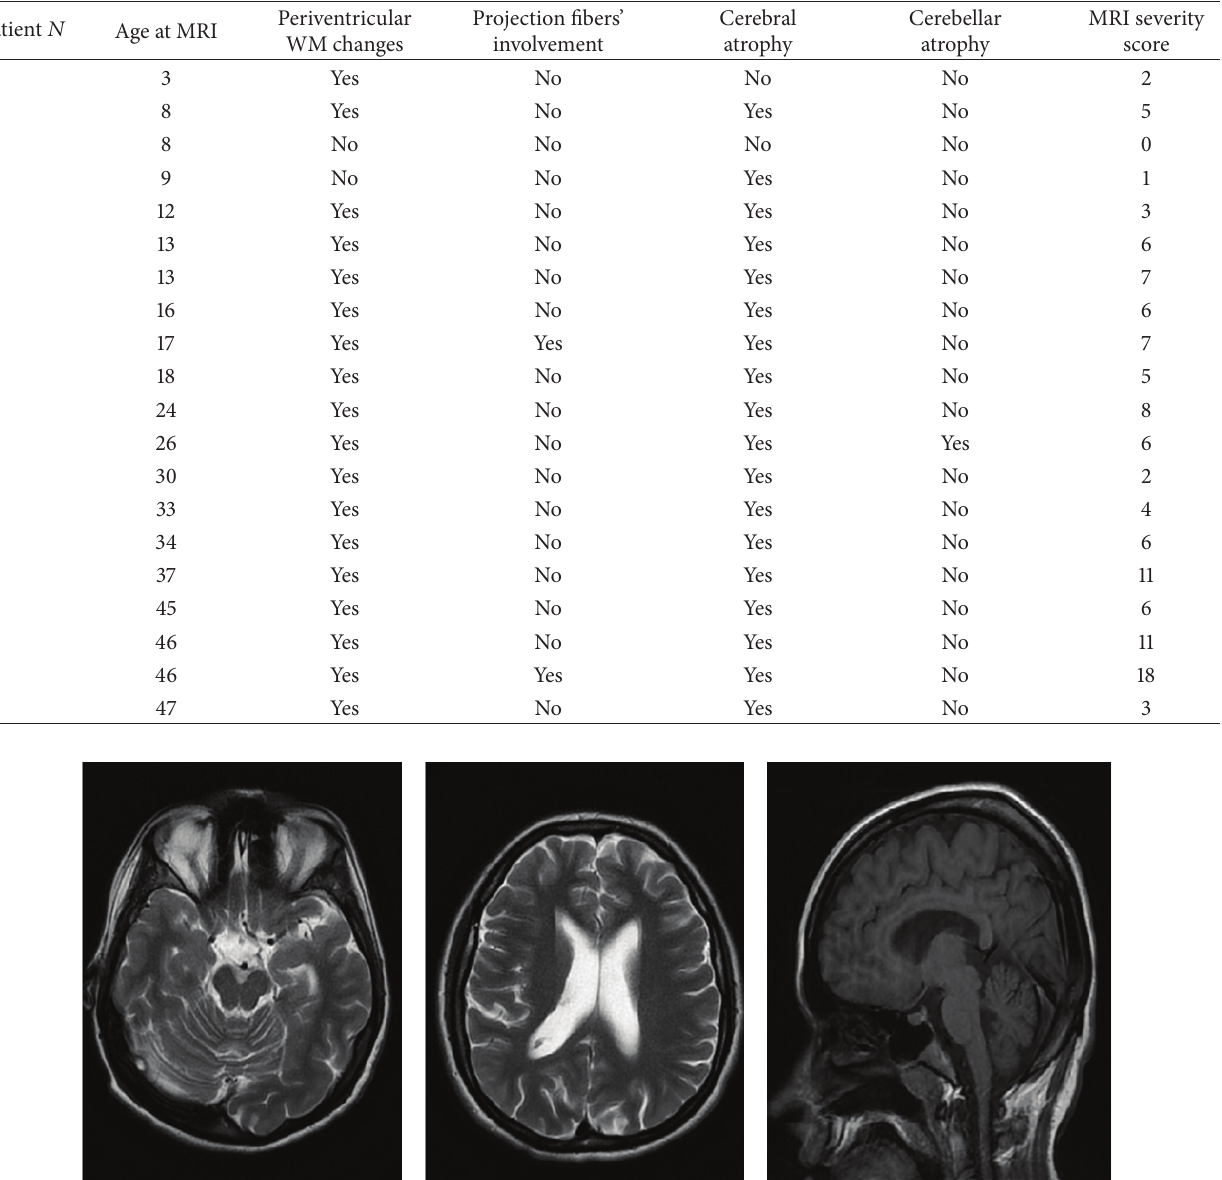
Table 5: Summary of MR imaging features in the CCFDN group.